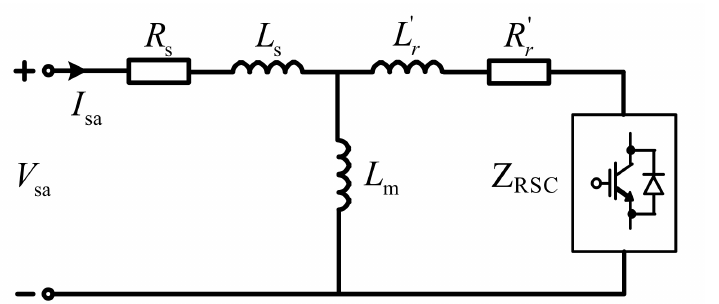
Figure 2. Equivalent circuit of induction generator and